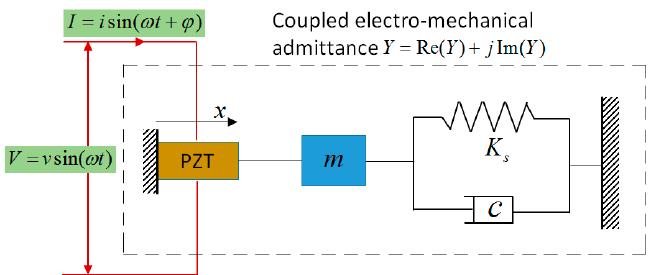
Figure 1. One-dimensional electro-mechanical system.